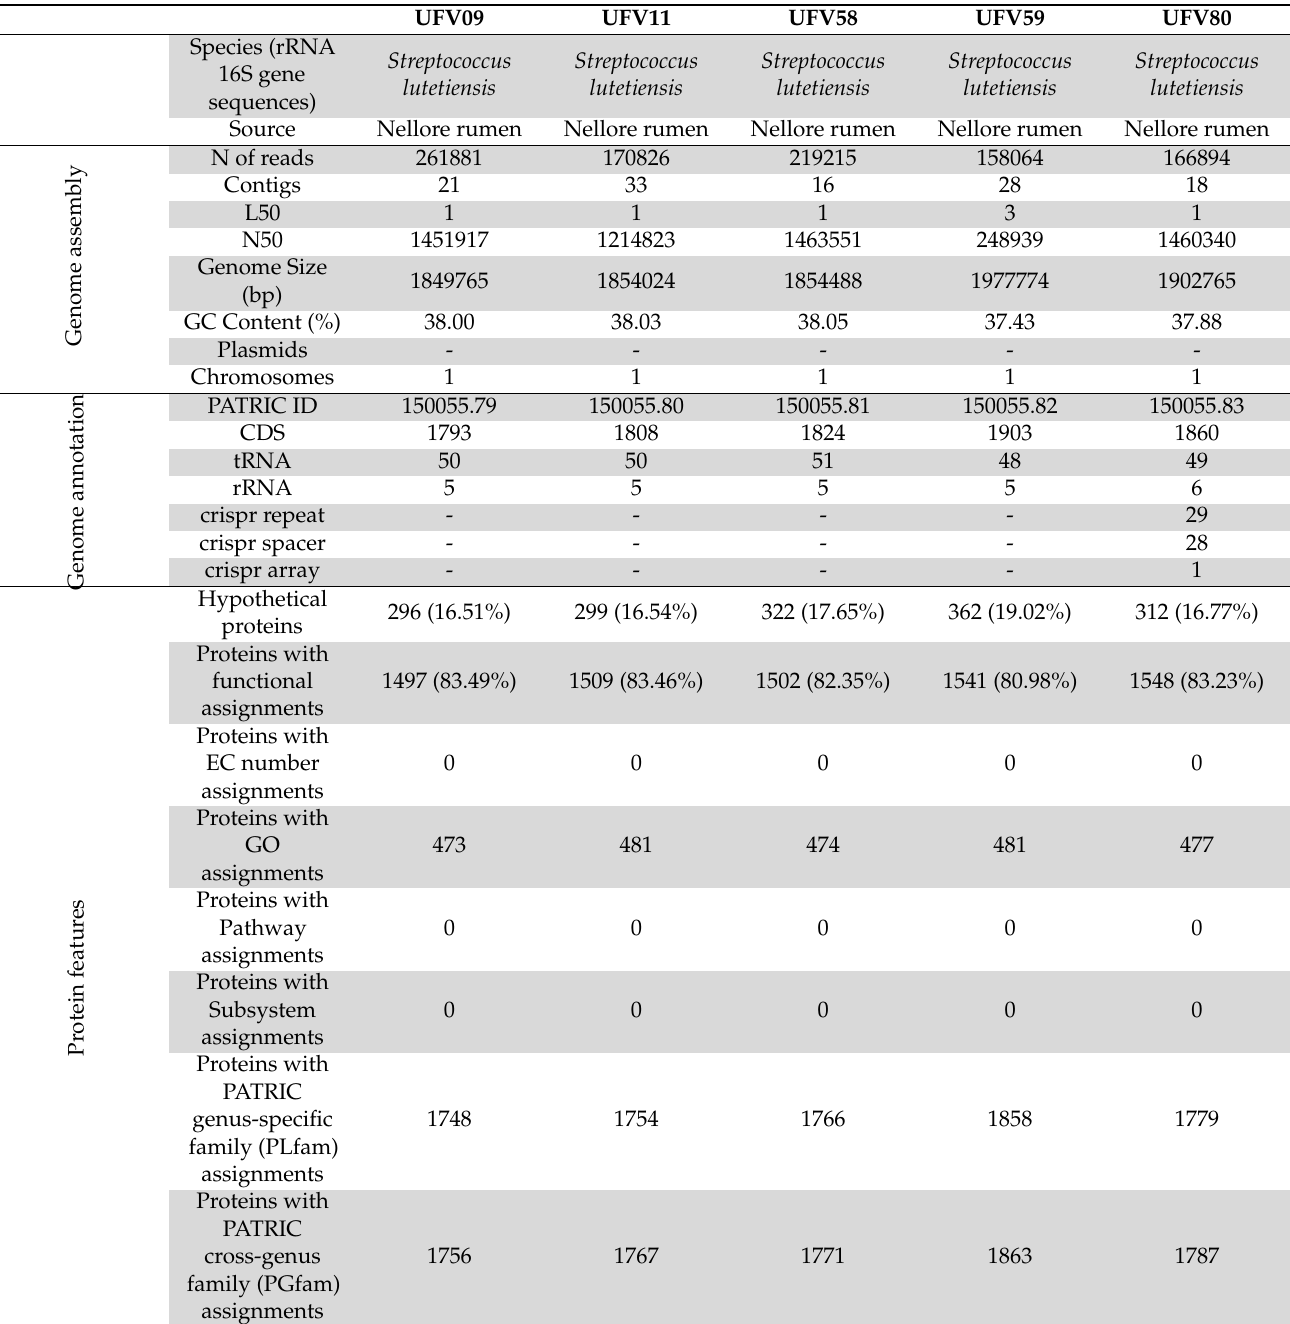
Table 2. Genomic features of the ruminal Streptococcus lutetiensis